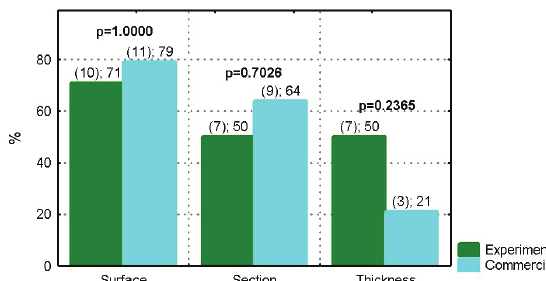
Figure 7: The statistics of the in vitro experiment.